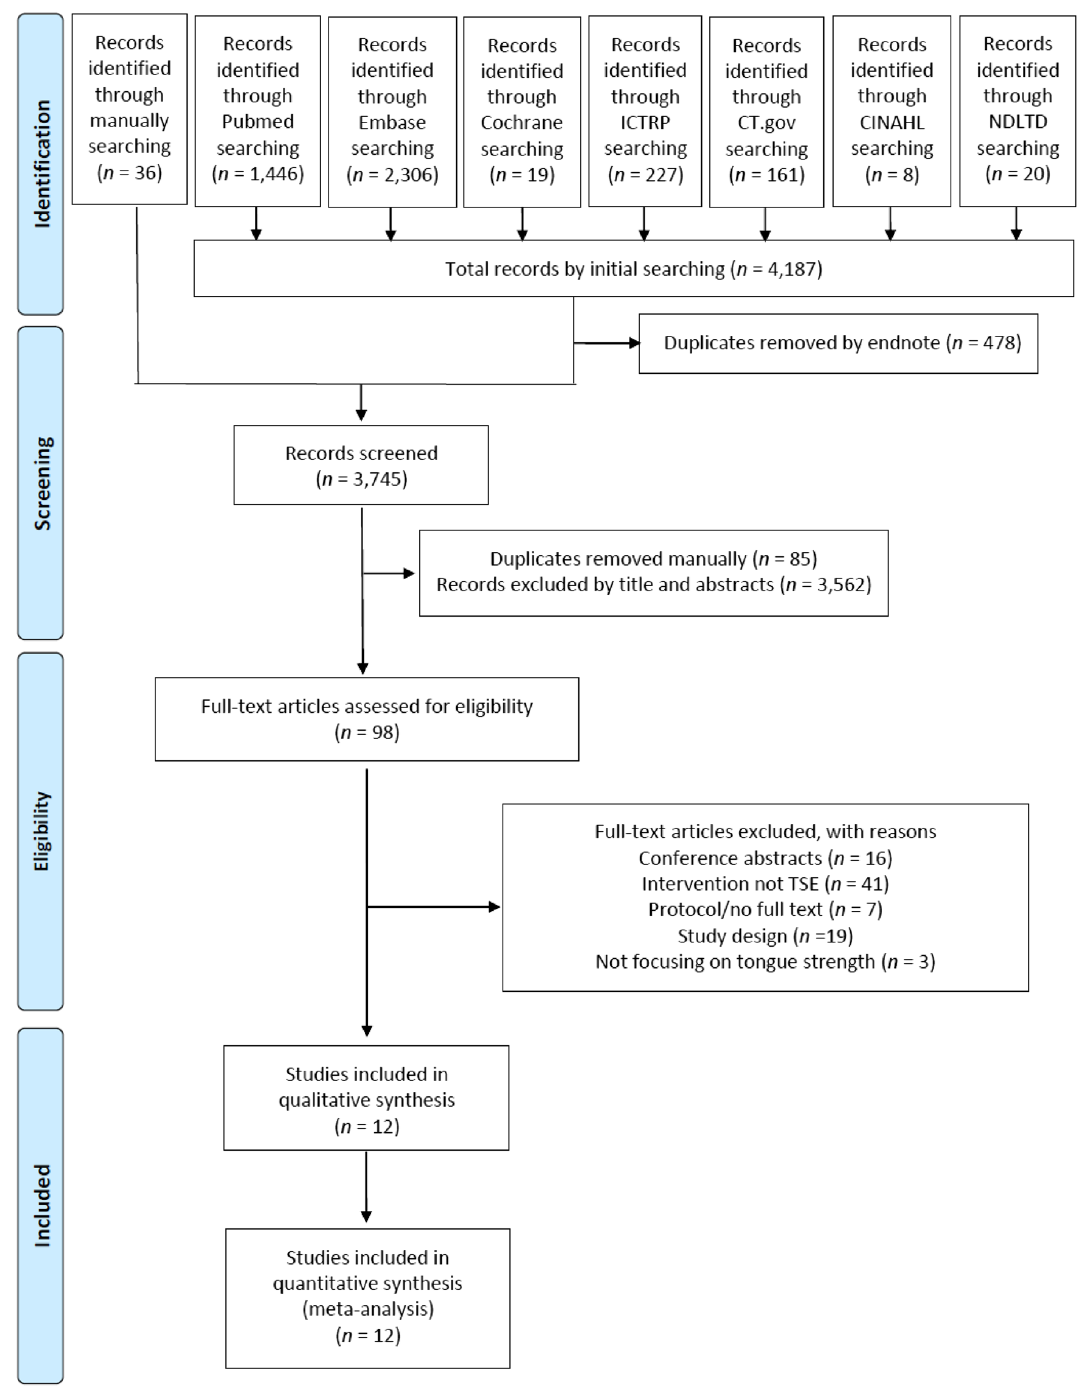
Figure 1. Flowchart of the study selection process. ICTRP International Clinical Trials Registry Platform, CT. gov ClinicalTrials.gov, CINAHL Cumulative Index to Nursing and Allied Health Literature, NDLTD the net worked digital library of theses and